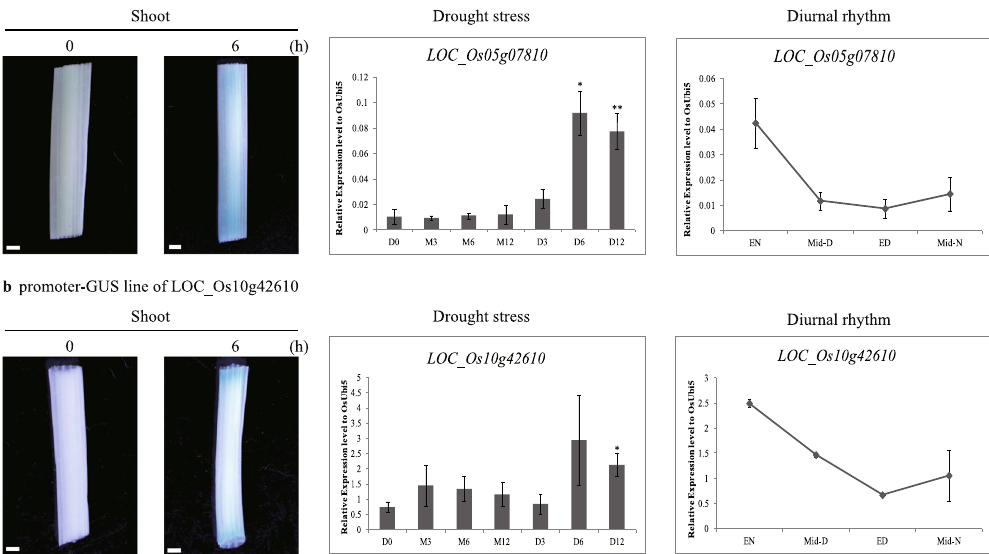
Figure 2. Validation of differential expression patterns under drought for two candidate genes using GUS reporter system and qRT-PCR. Results of qRT-PCR analyses: ( a ) drought-inducible GUS expression of LOC- Os05g07810 by promoter trap system, and its expression level under drought stress and diurnal rhythm relative to OsUbi5 ; and ( b ) drought-inducible GUS expression of LOC_Os10g42610 by promoter-GUS vector system, and its expression level under drought stress and diurnal rhythm relative to OsUbi5 . D0, untreated leaf sample; M3, MOCK (Control) monitored for 3 h after drought stress; M6, MOCK after 6 h; M12, MOCK after 12 h; D3, leaf sample under drought for 3 h; D6, leaf sample under drought for 6 h; D12, leaf sample under drought for 12 h. For analyses of diurnal expression: EN, leaf sample collected at end of night; Mid-D, mid-day; ED, end of day; and Mid-N, middle of night. OsUbi5 was used as internal control for qRT-PCR analysis. Error bars indicate standard errors of 3 replicates. * , ** , *** , and **** : values are significantly different from each other at P ≤ 0.05, P ≤ 0.01, P ≤ 0.001, and P ≤ 0.0001,